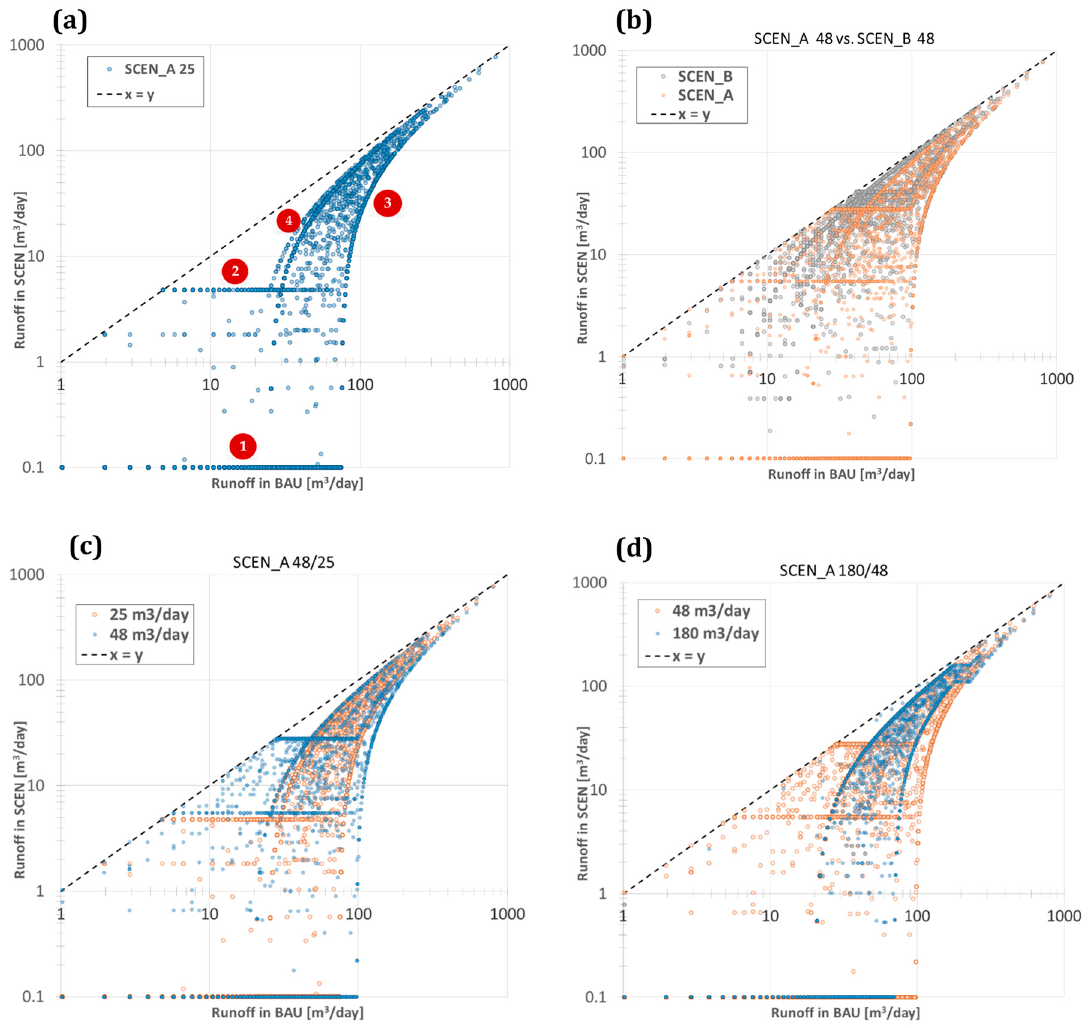
Figure 10. Event-based runoff reduction for different SUPERLOCAL design options and attributes.